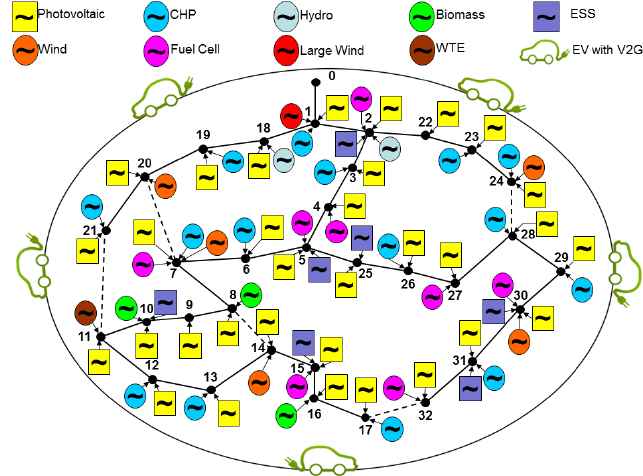
Figure 3. Thirty-three-bus network configuration (reprint with permission [25]; 2012, Elsevier).